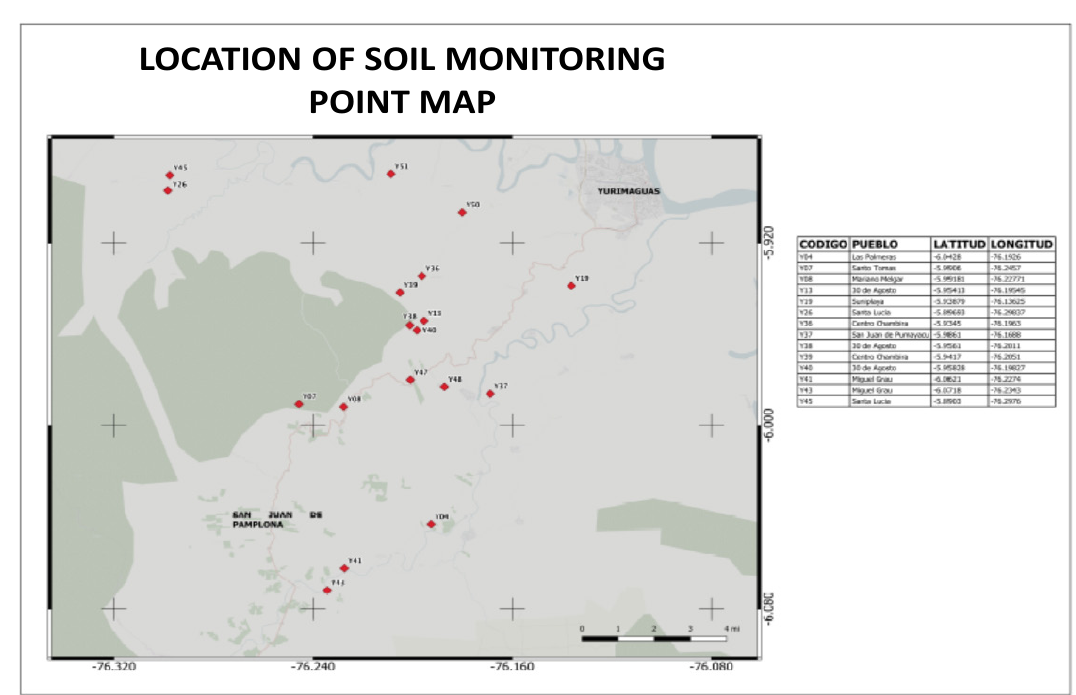
Figure 1. Location map of the farms in the district of Yurimaguas (Loreto) that participated in the Sustainable Landscapes for the Amazon project, according to geo-referencing (elaboration: Bach. André Mauricio Valderrama Espinoza)